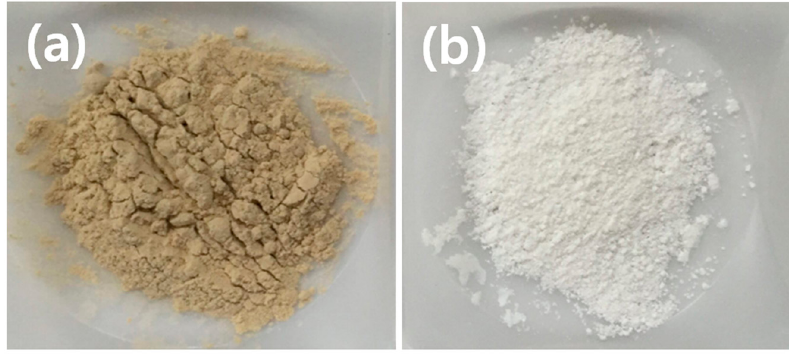
Figure 11. ( a ) The blast furnace slag as-received and ( b ) carbonated product obtained after removing silica-rich gel.